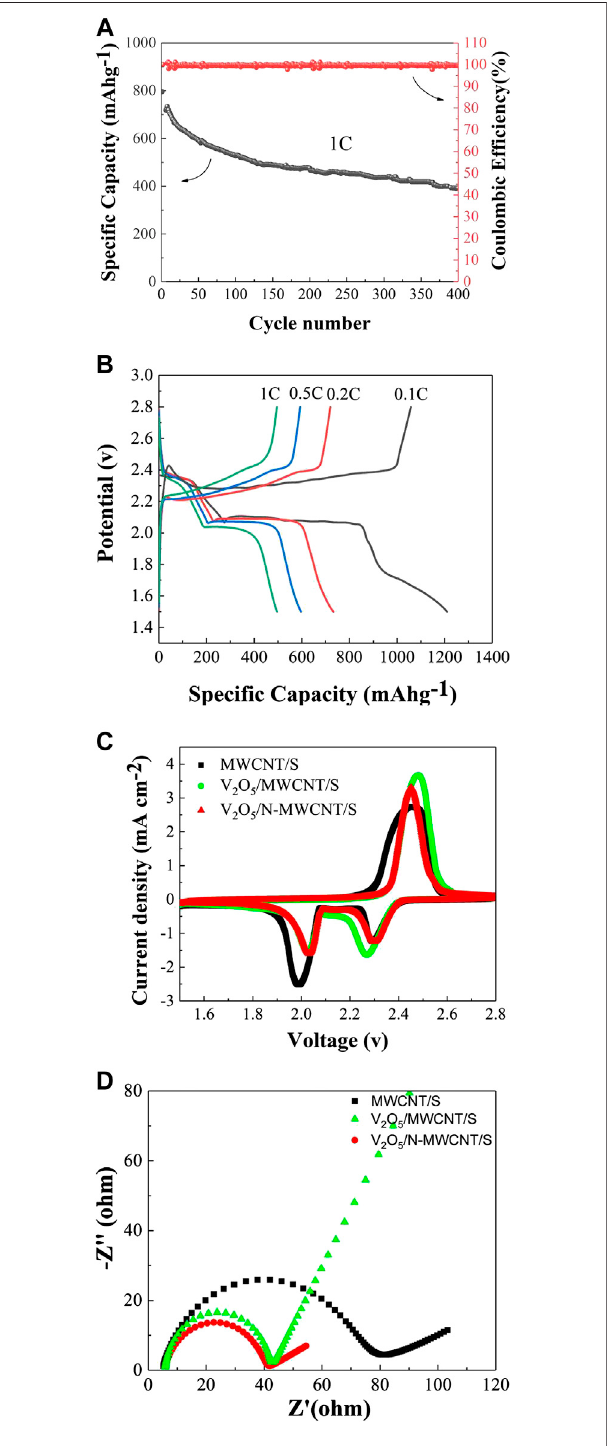
FIGURE 7 | (A) Long cycle performance of the V 2 O 5 /N-MWCNT/S compositematerialat1 C . (B) InitialchargeanddischargecurvesoftheV 2 O 5 / N-MWCNT/S composite material. (C) CV curves of the V 2 O 5 /N-MWCNT/S, V 2 O 5 /MWCNT/S, and MWCNT/S composite materials. (D) EIS spectra of the V 2 O 5 /N-MWCNT/S, V 2 O 5 /MWCNT/S, and MWCNT/S composite